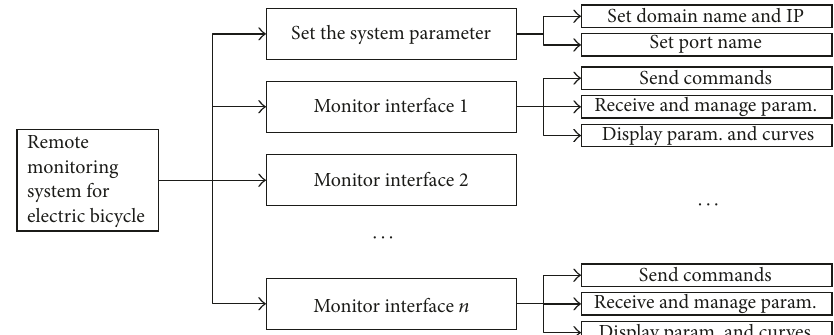
Figure 8: Framework of Android client.